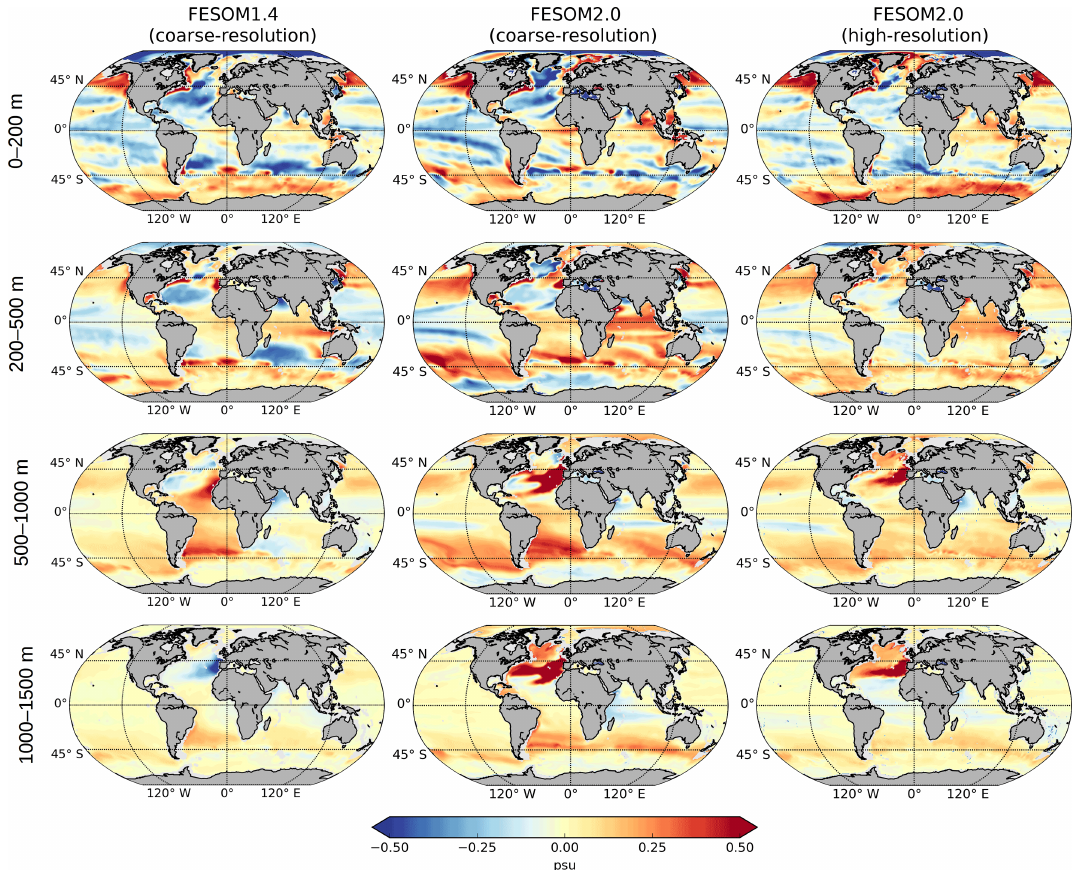
Figure 4. The same as in Fig. 3 but for